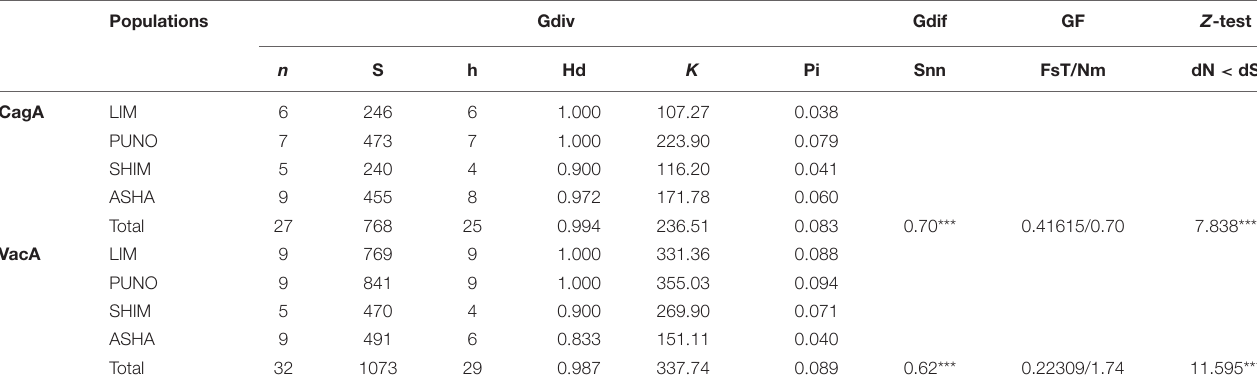
TABLE 2 | Population and evolutionary statistics for cagA and vacA . Gdiv, genetic diversity estimators; n, number of sequences; S, number of segregating sites; h, number of haplotypes; Hd, haplotype diversity; K, average number of differences; Pi, Nucleotide diversity. Populations Gdiv Gdif GF Z -test n S h Hd